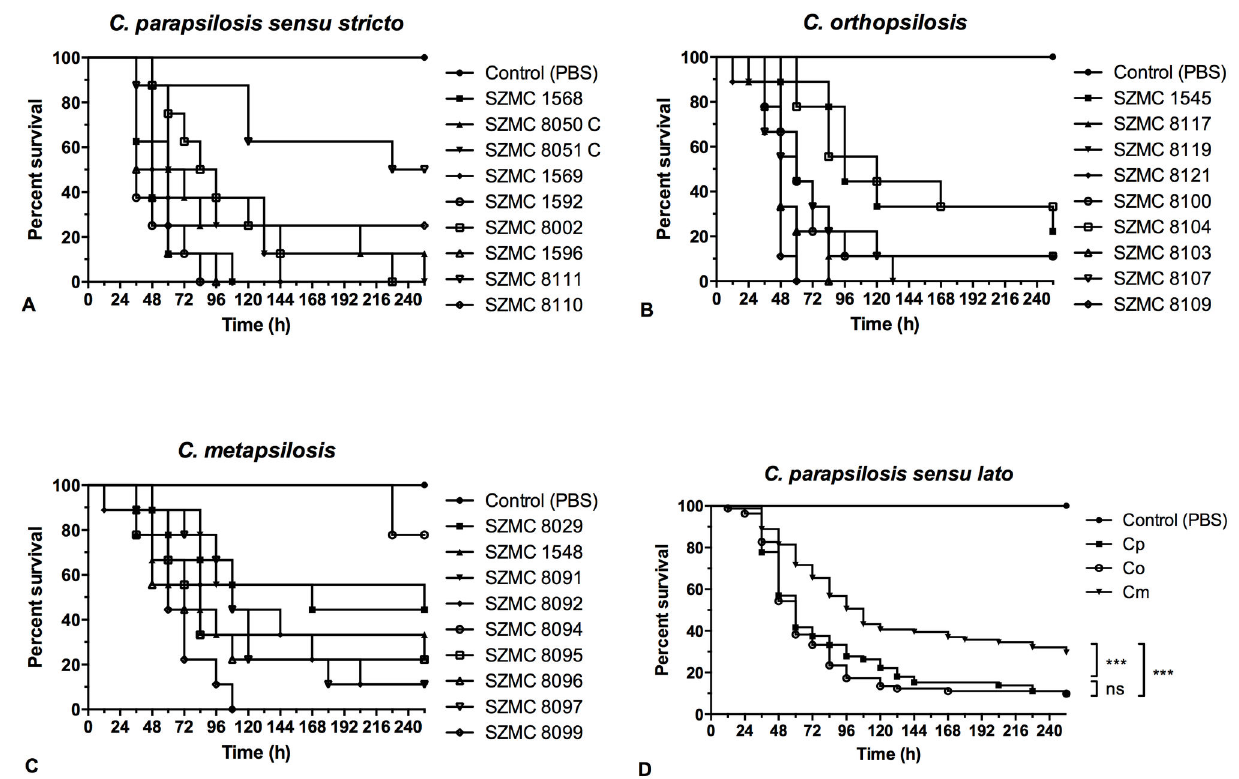
Figure 5. Survival of Galleria mellonella larvae infected with different isolates of (A) C. parapsilosis sensu stricto , (B) C. orthopsilosis and (C) C. metapsilosis . For C. parapsilosis sensu stricto isolates, each survival group contained 8 larvae, whereas 9 larvae per group were used to assess survival after C. orthopsilosis or C. metapsilosis infection. (D) Summarized survival curve